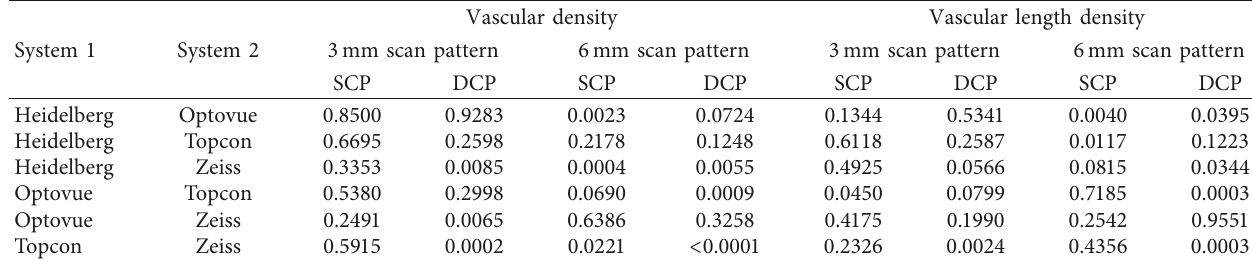
Table 4: P values for comparison of the intraclass correlation coefficients of vessel density and vessel length density measurements derived with the four optical coherence tomography angiography systems.